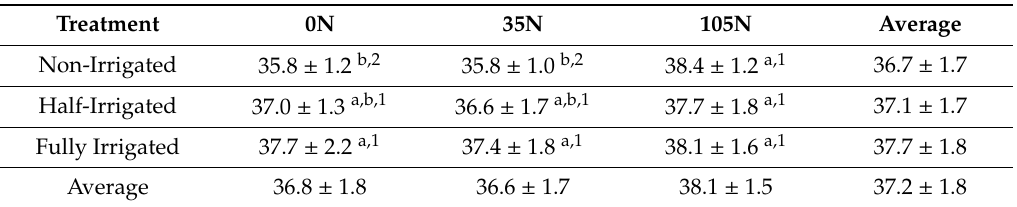
Table 17. The e ff ect of di ff erent fertilization rates on the seed protein concentration (%) of soybean (cv. Pannonia Kincse) under di ff erent irrigation regimes, averaged among 2017, 2018, and 2019 in Debrecen, Hungary.